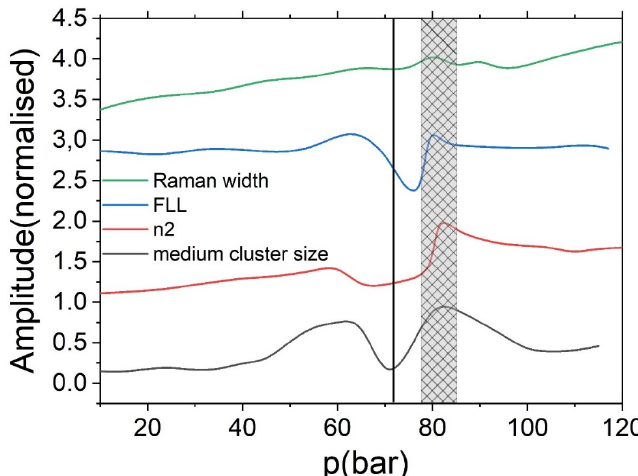
Figure 5. Normalized (on maximal value) dependence of the Raman peak width (green line), function of Lorentz–Lorenz (blue line), nonlinear refractive index (red line) and medium cluster size (black) line at 305 K. The vertical black line shows critical pressure. The shaded region shows approximate location of the Widom delta.